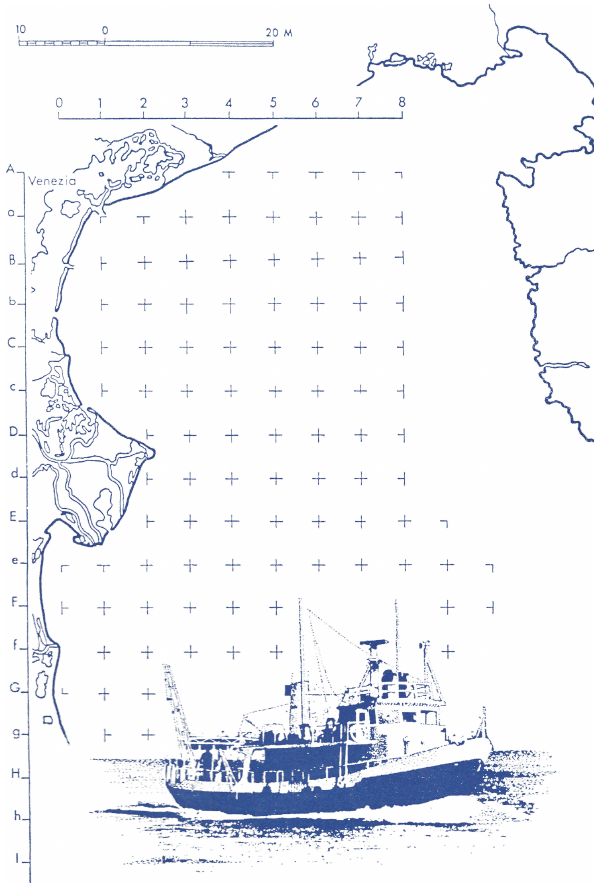
Figure 2. An example of sampling stations based on the regular grid created in the NAS for the cruises from 1966 to 1980 (from Franco,